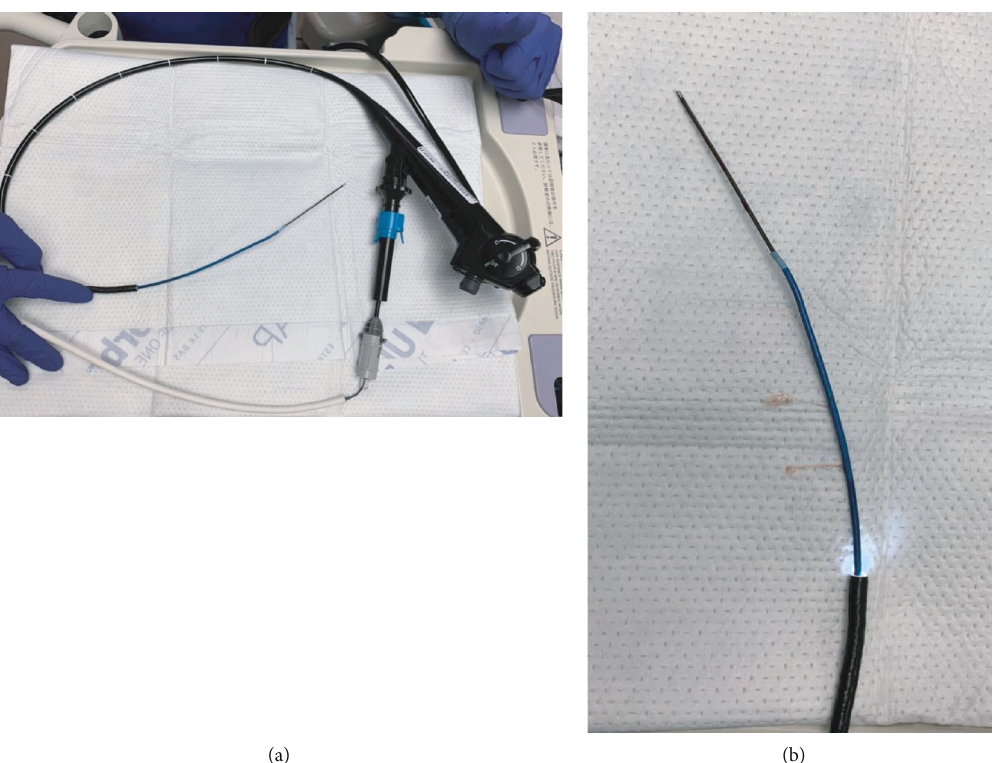
Figure 5: Equipment used for the TBC navigational bronchoscopy. (a) Proximal to distal: Olympus therapeutic bronchoscope, Edge ™ extended working channel, fl exible single use 1.7mm cryoprobe catheter (ERBECRYO®